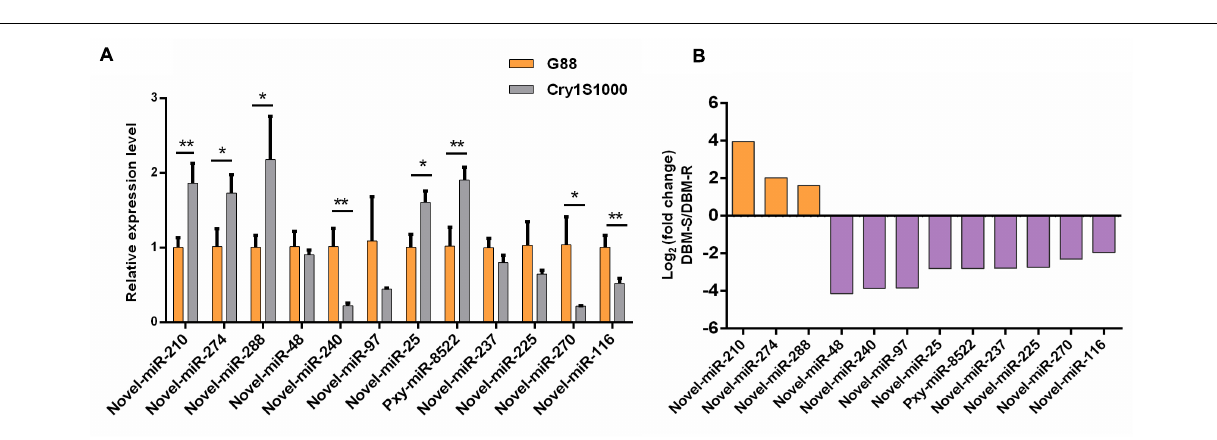
FIGURE 7 | Relative expression levels of differentially expressed miRNAs in midguts of the resistant (Cry1S1000) and susceptible (G88) strains by RT-qPCR (A) , and up-/down-regulated expression of the miRNAs based on Illumina sequencing (B). The expression levels of miRNAs were normalized by U6. Statistical significance was analyzed using one-way ANOVA. The asterisks represent significance, where two asterisks indicate p < 0.01, and one asterisk indicates p < 0.05. (B) The orange column above the X-axis shows up-regulated miRNAs, while the purple column below the X-axis shows down-regulated miRNAs based on Illumina